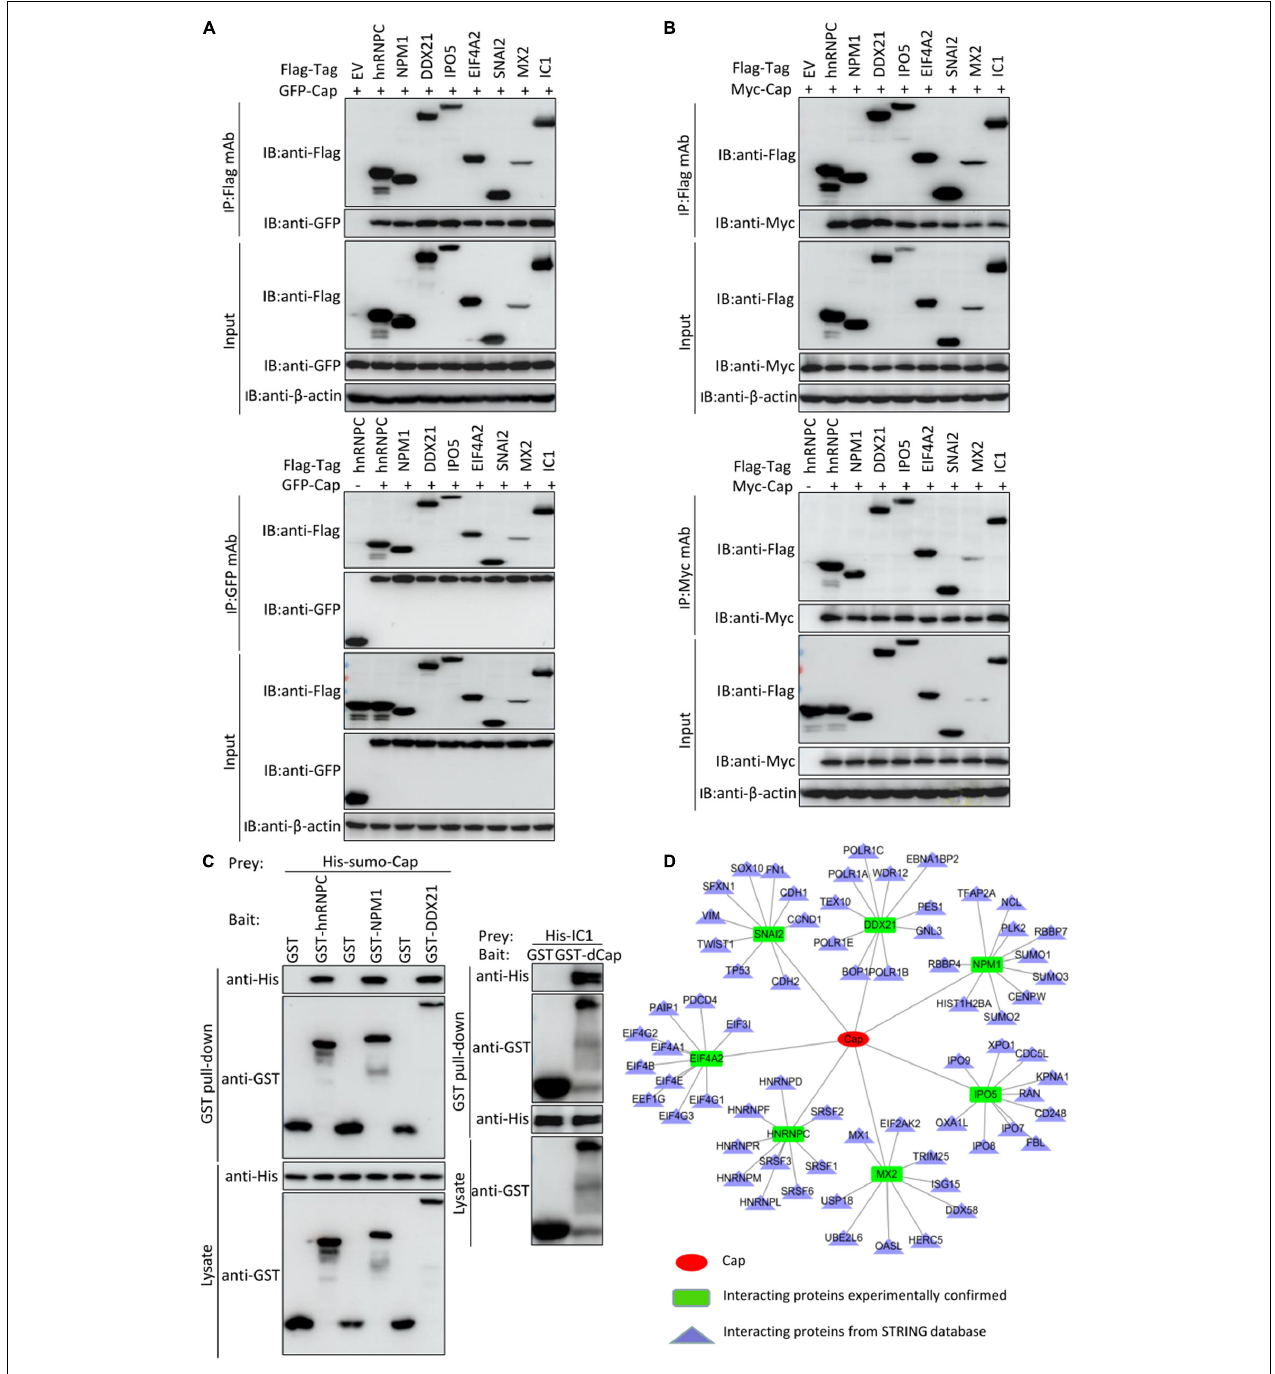
FIGURE 5 | Validation of Cap-host protein interactions. (A,B) HEK-293T cells were co-transfected with plasmids expressing FLAG-hnRNPC, FLAG-NPM1, FLAG-DDX21, FLAG-IPO5, FLAG-EIF4A2, FLAG-SNAI2, FLAG-MX2, or FLAG-IC1 and plasmids expressing GFP-Cap (A) , Myc-Cap (B) , respectively. Among them, GFP-Cap (A) , Myc-Cap (B) , FLAG-hnRNPC (A,B) co-transfected with empty vector were served as negative controls and GFP-Cap (A) , Myc-Cap (B) co-transfected with FLAG-IC1 were served as positive controls, respectively. The cell lysates were immunoprecipitated with FLAG beads, anti-GFP, or anti-Myc mAbs, separated by SDS-PAGE, western-blotted and detected with corresponding antibodies, respectively. β -actin was served as internal loading control. (C) Purified His-sumo-Cap was separately added to the GST, GST-hnRNPC, GST-NPM1, GST-DDX21 proteins and His-IC1 was also separately added to the GST, GST-dCap proteins and then subjected to GST pull-down assays and immunoblotted with corresponding antibodies, respectively. (D) PCV2 Cap-host interactions network. Interaction map of PCV2 Cap with interacting host proteins was constructed by software Cytoscape 3.7.1. Proteins were classified on the basis of their protein class. The corresponding symbols indicating different protein classes have been mentioned on the figure ( Supplementary Table S6 ).